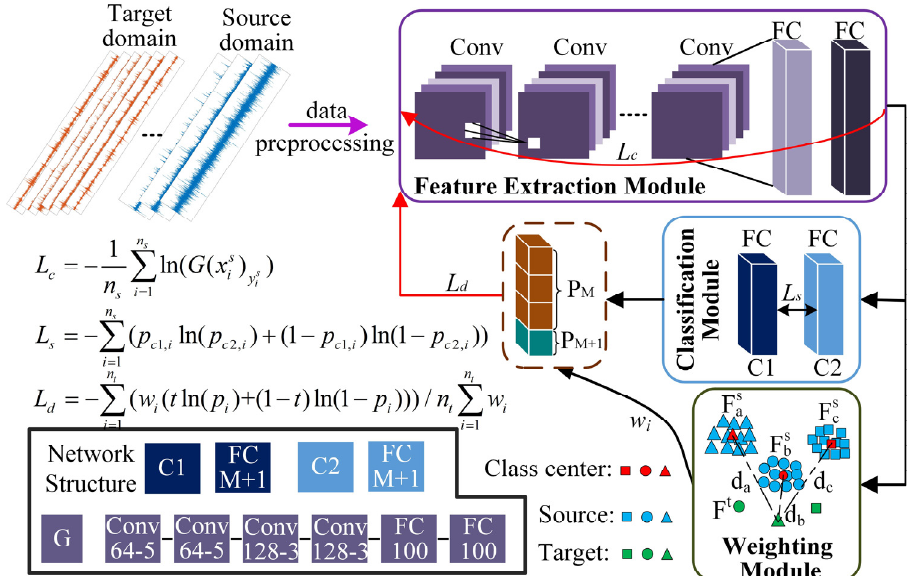
Figure 3. The training process and model structure of the proposed method.